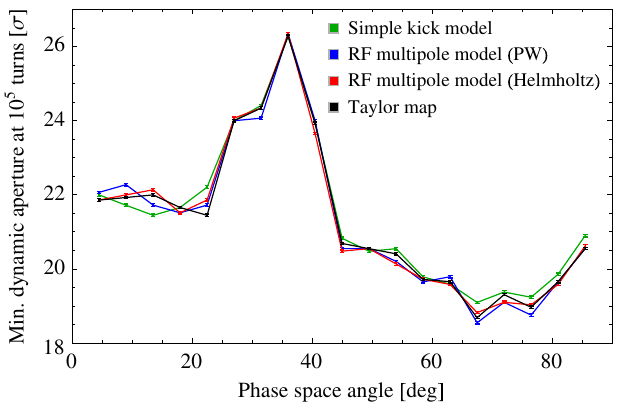
FIG. 7. Impact of different crab cavity models on the minimum dynamic aperture after 10 5 turns, comparing the 500 coefficient Taylor map with the rf-multipole kick model (using multipoles calculated using the Helmholtz and PW decompositions) and the simple